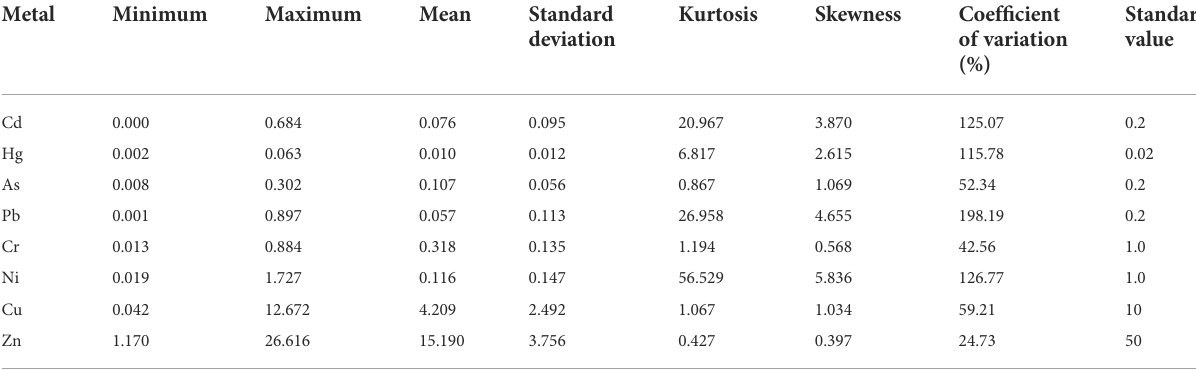
TABLE 2 Descriptive statistics of heavy metal content in rice